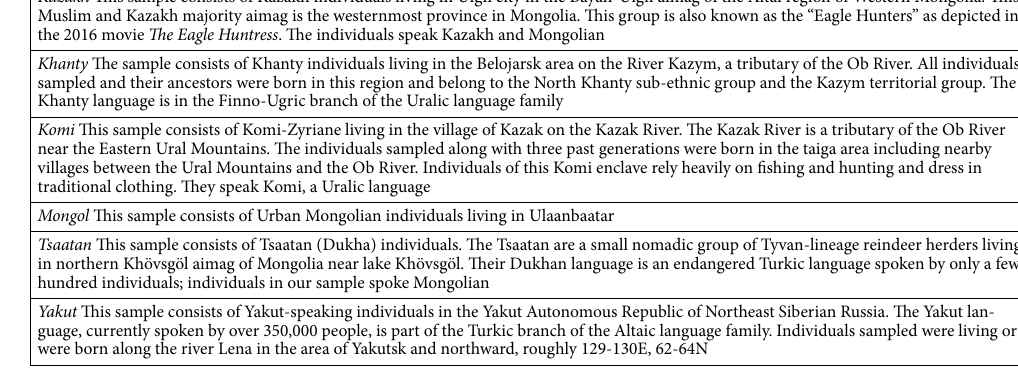
Table 1. North Asian population samples studied in the Kidd